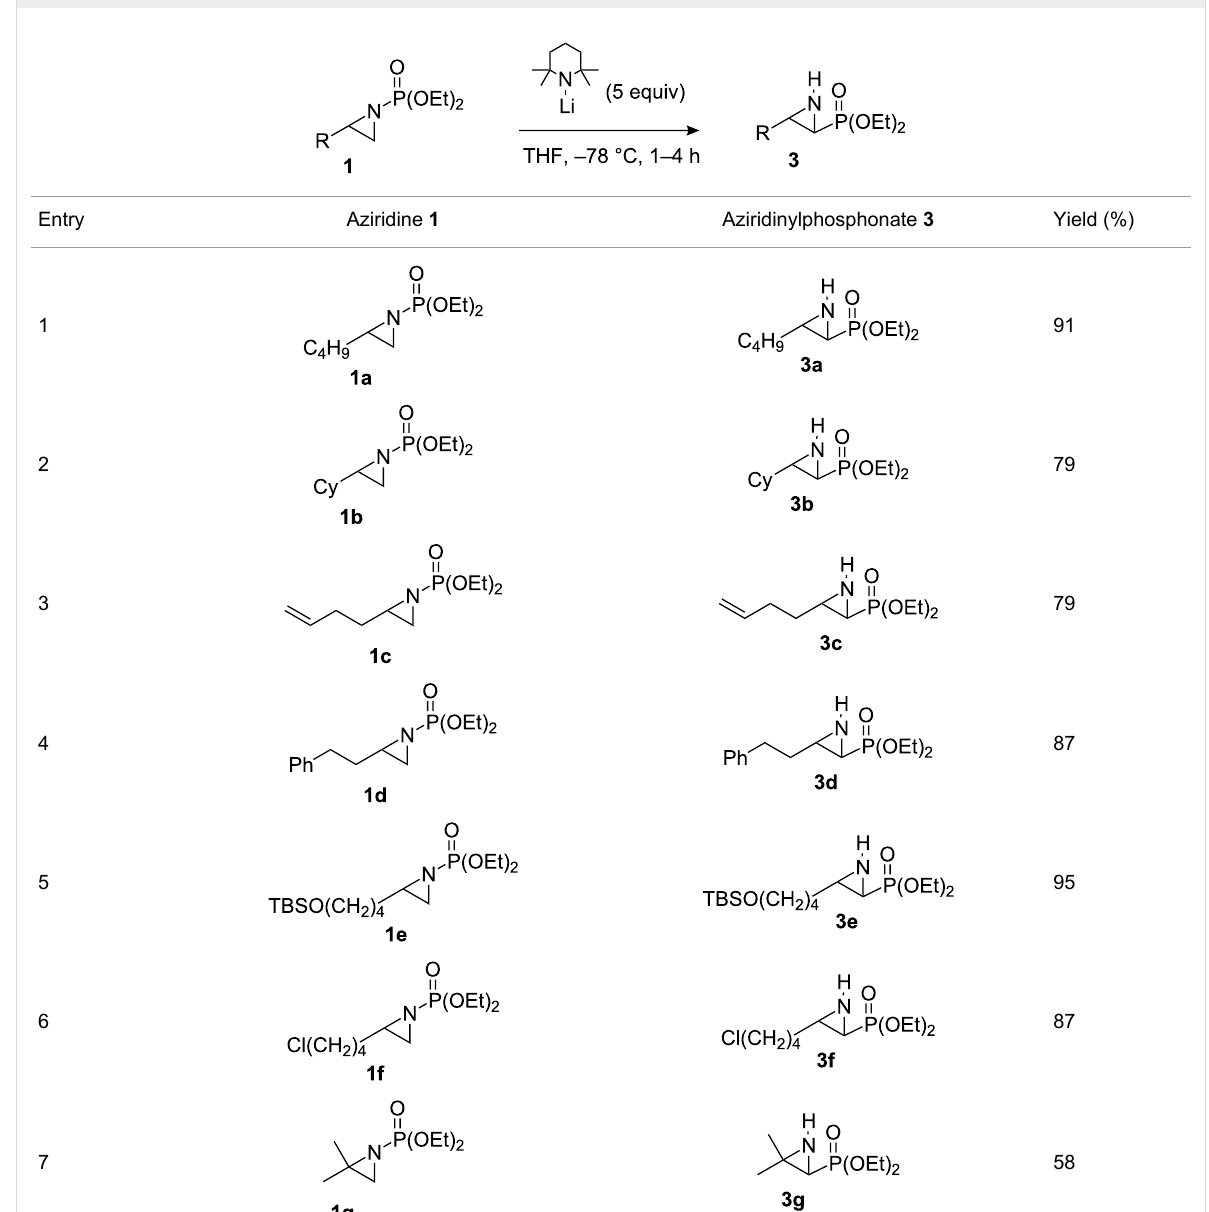
Table 1: Aziridinylphosphonate 3